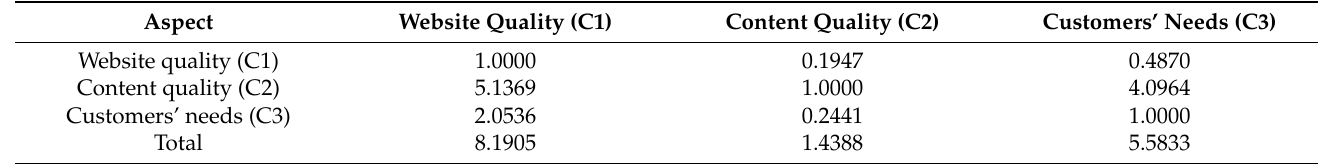
Table 7. The crisp matrix of the G-AHP model.